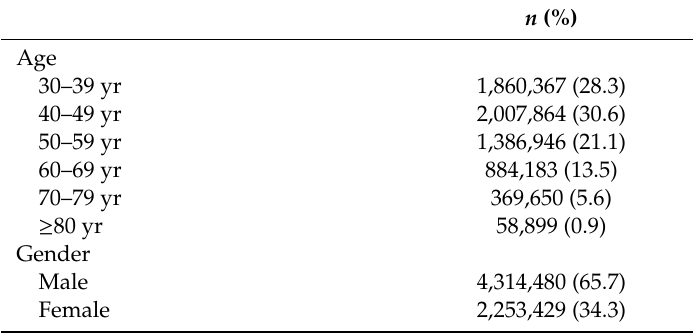
Table 2. General characteristics of the study subjects ( n =